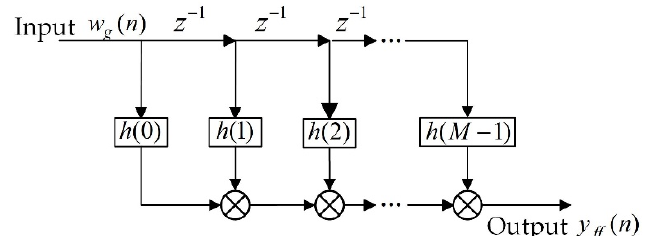
Figure 4. FIR control system structure.